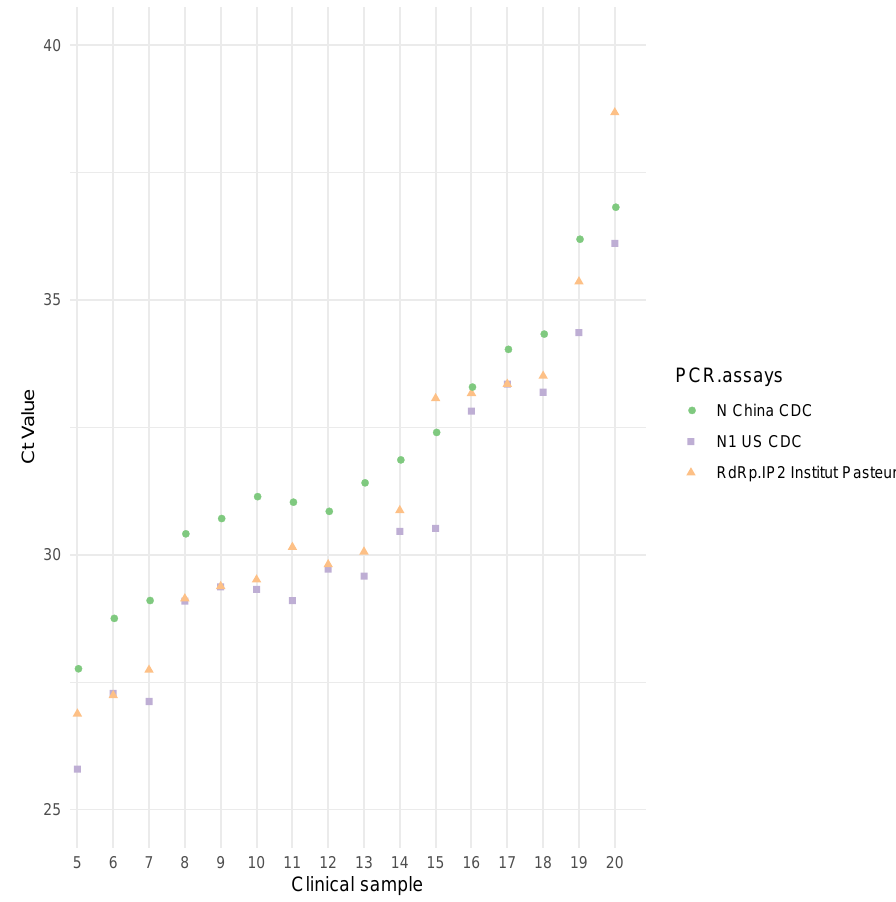
Figure 2. Ct values for 16 positive clinical samples using the three most sensitive assays. N China CDC is represented by green circles, N1 US CDC by purple squares, and RdRp IP2 Institut Pasteur, Paris, by orange triangles.